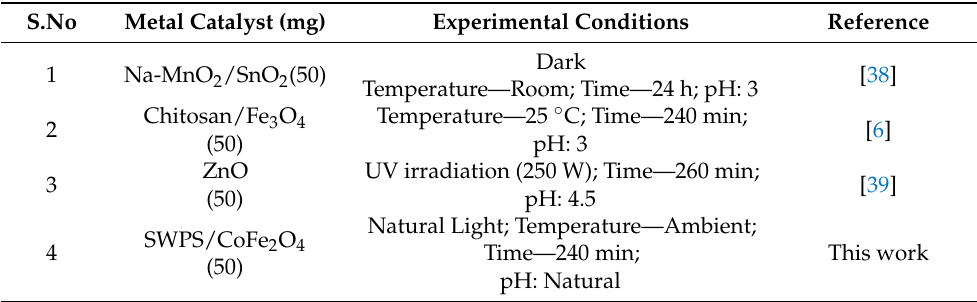
Table 2. List of metal catalysts in the dye degradation process.